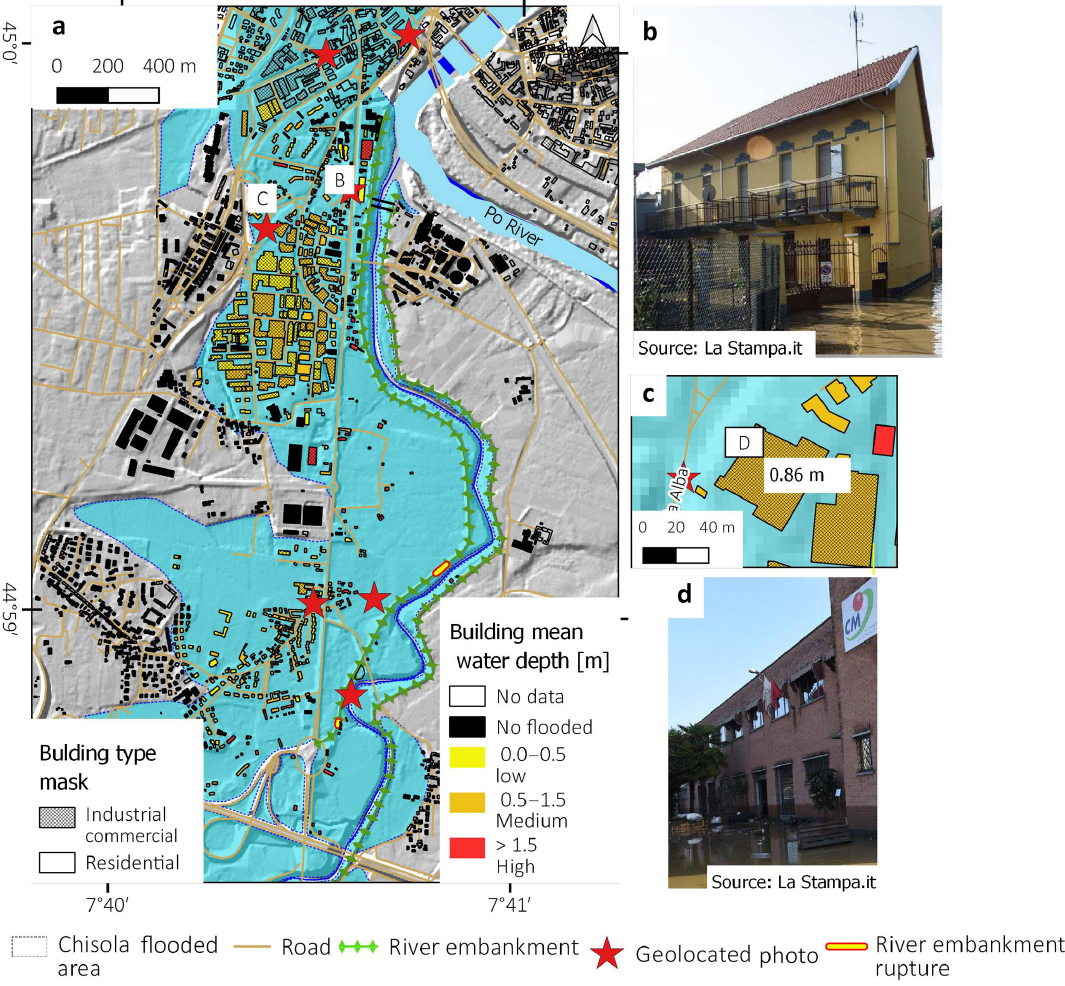
Figure 12. (a) Water level height map based on SfM data and 5m DTM model; (c) Zoom on the building of panel (d) ; (b) and (d) Photo where it is possible to observe the water depth from the newspaper “La Stampa” geolocated using Google